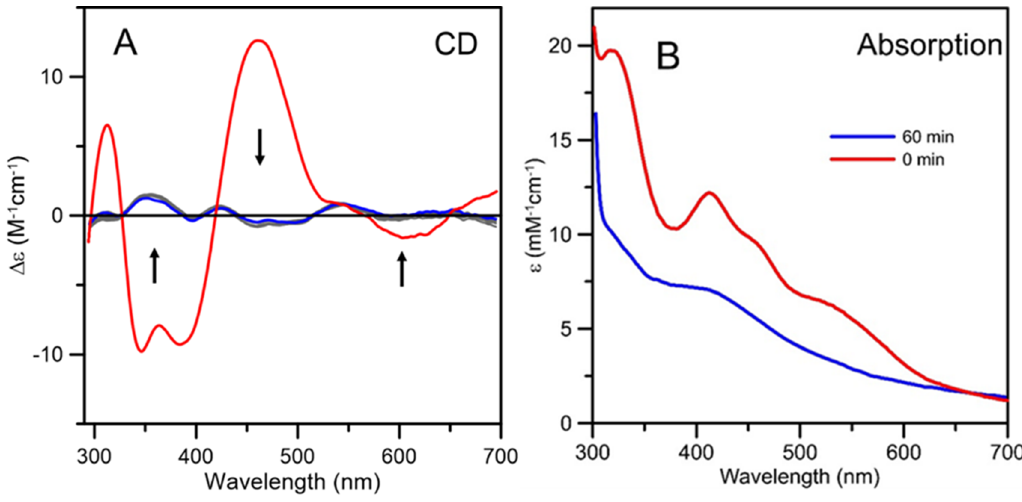
Figure 9. Cluster transfer from At [2Fe-2S] 2 + -GRXS15 to At apo-ISCA1a / 2 monitored by UV-visible absorption and CD spectroscopy as a function of time. ( A ) The thick red line is the CD spectrum of [2Fe-2S] 2 + cluster-bound GRXS15 before addition of At apo-ISCA1a / 2 to the reaction mixture. The thin grey lines are CD spectra of the reaction mixture, GRXS15 (60 µ M in [2Fe-2S] 2 + clusters) mixed with DTT-pretreated apo-ISCA1a / 2 (30 µ M) in 100 mM Tris-HCl, pH 7.8, with 1 mM GSH, recorded at 1, 3, 5, 17, 20, 25, 28, 30, and 34 min after addition of apo ISCA1a / 2. The thick blue line corresponds to the final CD spectra after 60 min. The arrows indicate the direction of change in CD intensity with time at selected wavelengths and ∆ ε values are based on the initial concentration of [2Fe-2S] 2 + clusters in the reaction mixture. ( B ) The thick red line is the absorption spectrum of [2Fe-2S] 2 + cluster-bound GRXS15 before addition of At apo-ISCA1a / 2 to the reaction mixture. The thick blue line corresponds to the final absorption spectrum 60 min after addition of At apo-ISCA1a / 2 to the reaction mixture. ε values are based on the initial concentration of [2Fe-2S] 2 + clusters in the reaction mixture.